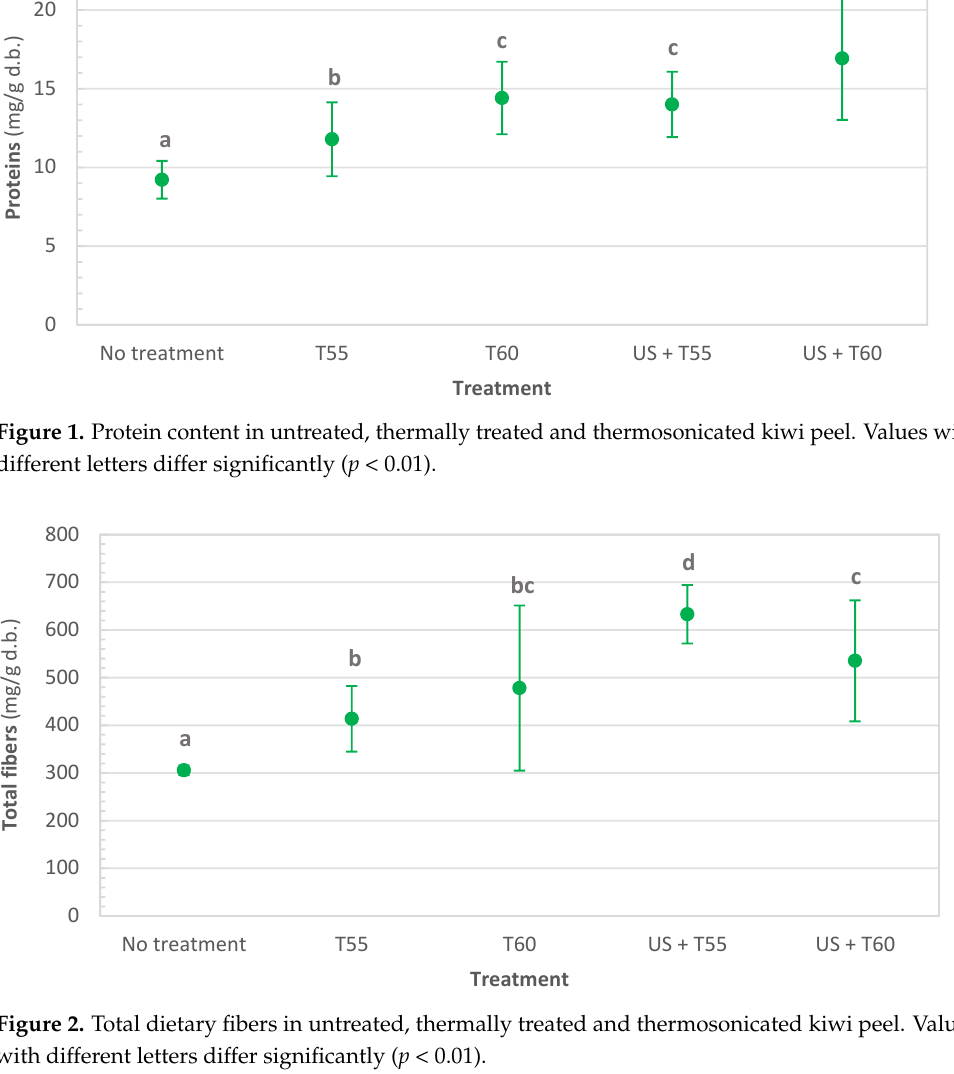
Figure 1. Protein content in untreated, thermally treated and thermosonicated kiwi peel. Values with different letters differ significantly ( p < 0.01 ).